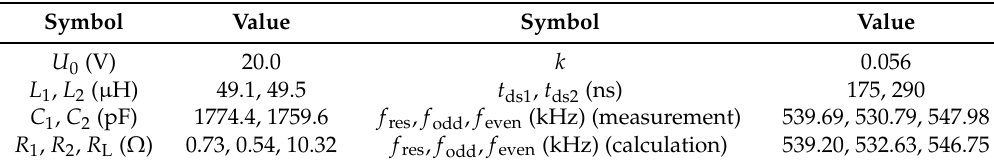
Table 2. Parameters of components.